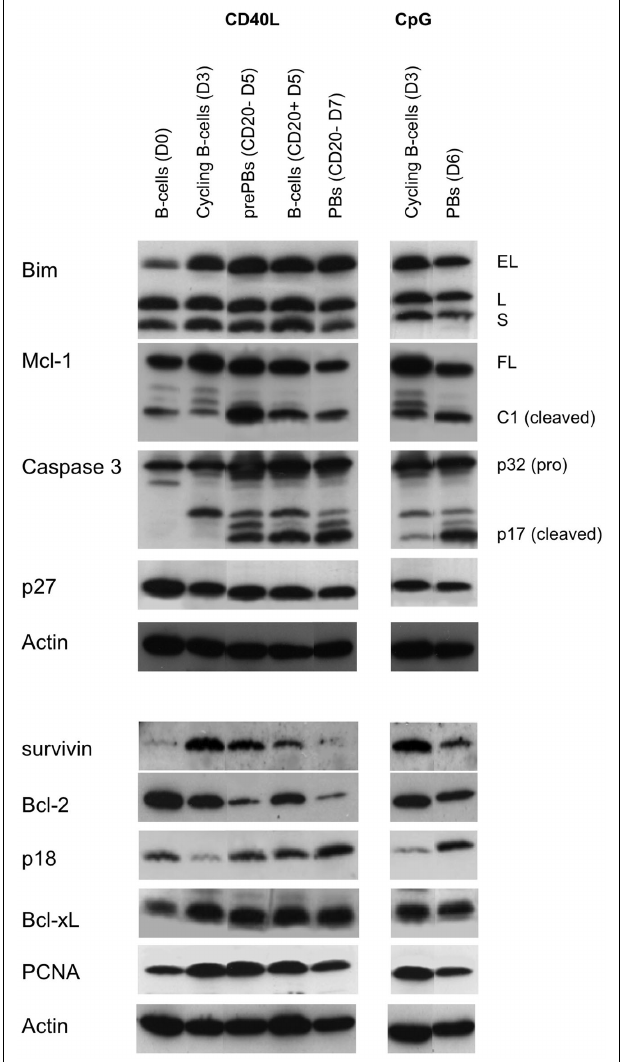
FIGURE 3 | Comparison of the expression profile of molecules controlling cell cycle and survival during PC generation. Tonsil CD27 + B-cells (Day 0) from two independent donors were cultured as described in Figure 1B . In the CD40L culture, prePBs (CD20 − Day 5) were purified as described in Figure 2B and further cultured for 2days with IL2 and IL10 (Day 7). Cells were lysed and lysates were equally divided in two samples. The same amount of proteins was loaded per lane and proteins were resolved by SDS-PAGE in two twin gels (i.e., two twin gels for the CD40L samples and two twin gels for the CpG samples).Western blot analysis was performed as described previously (Puthier et al., 1999; Ménoret et al., 2010). Membranes were probed, stripped, and reprobed with the antibodies in the order presented in the figure (Actin as last). EL, Bim extra large; L,